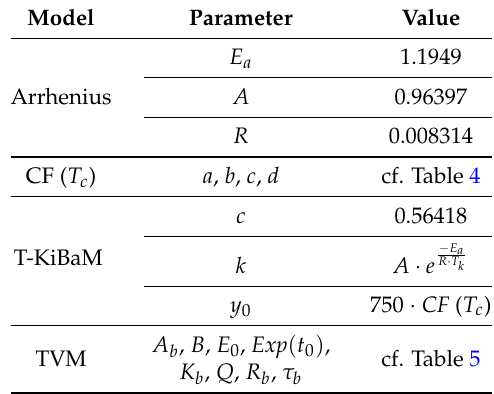
Table 6. Temperature-Dependent KiBaM (T-KiBaM) parameters for a Ni-MH